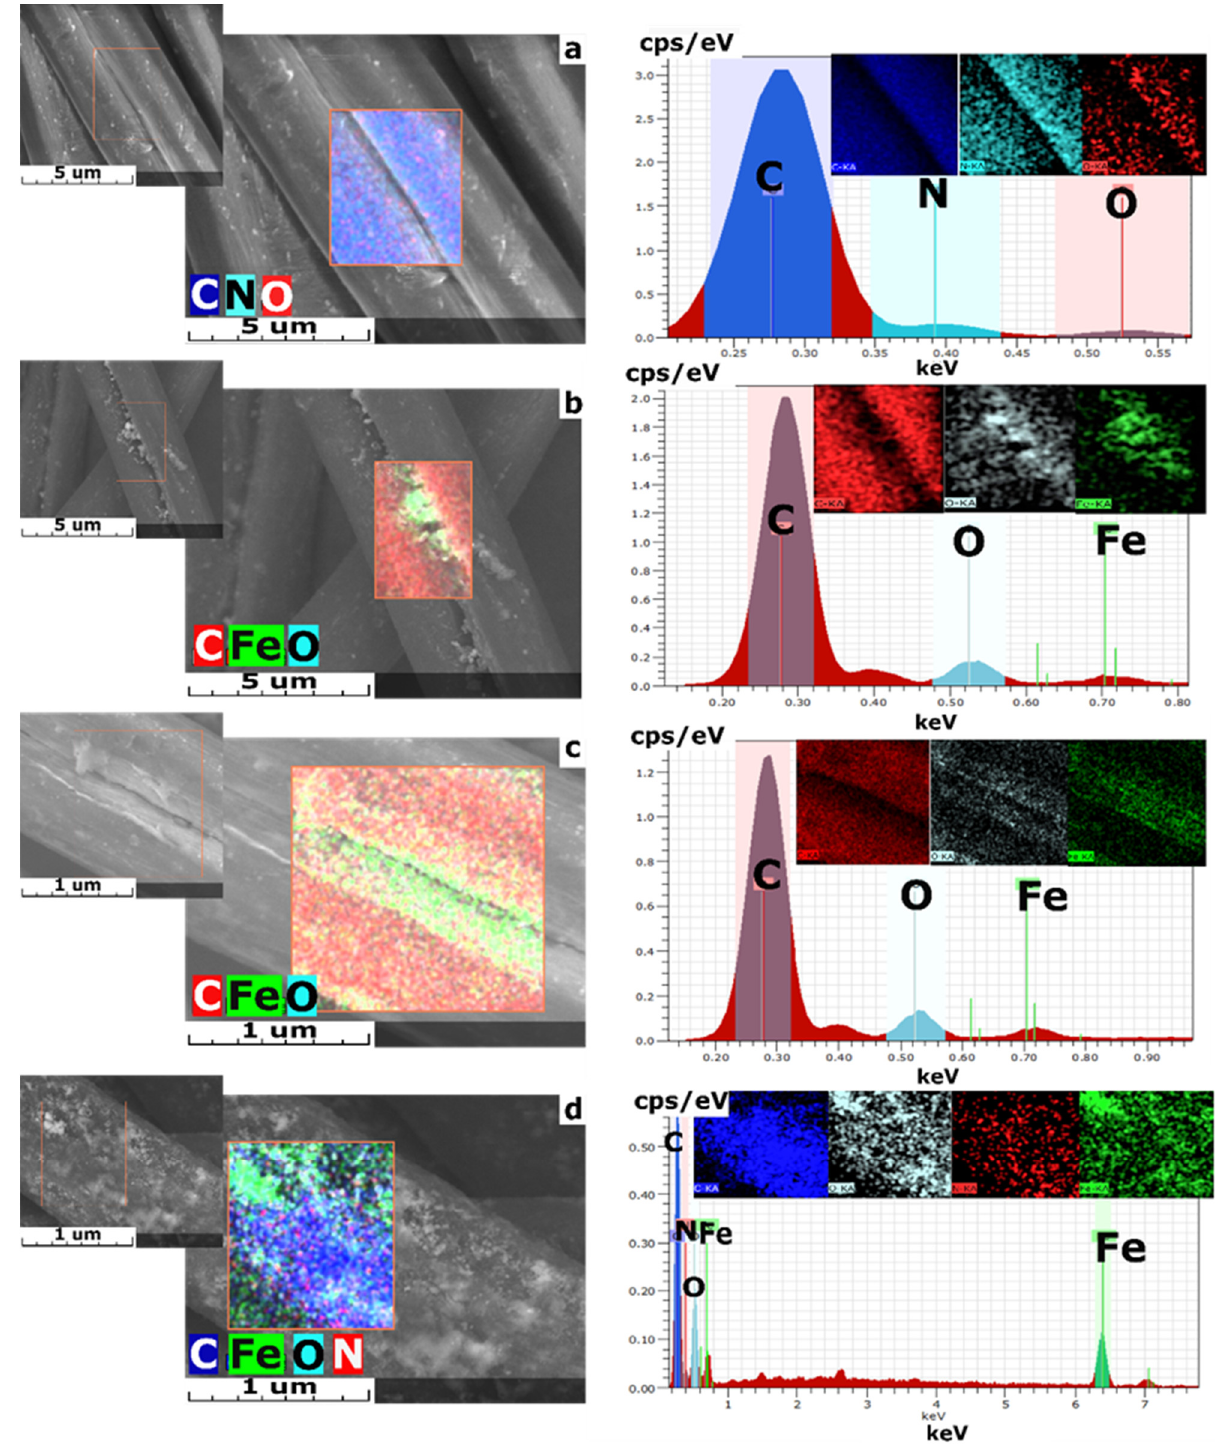
Figure 9. EDS analysis: ( a )—PAN; ( b )—Fe-SF, ( c )—Fe-NH; ( d )—Fe-H (100–50–30 microns).